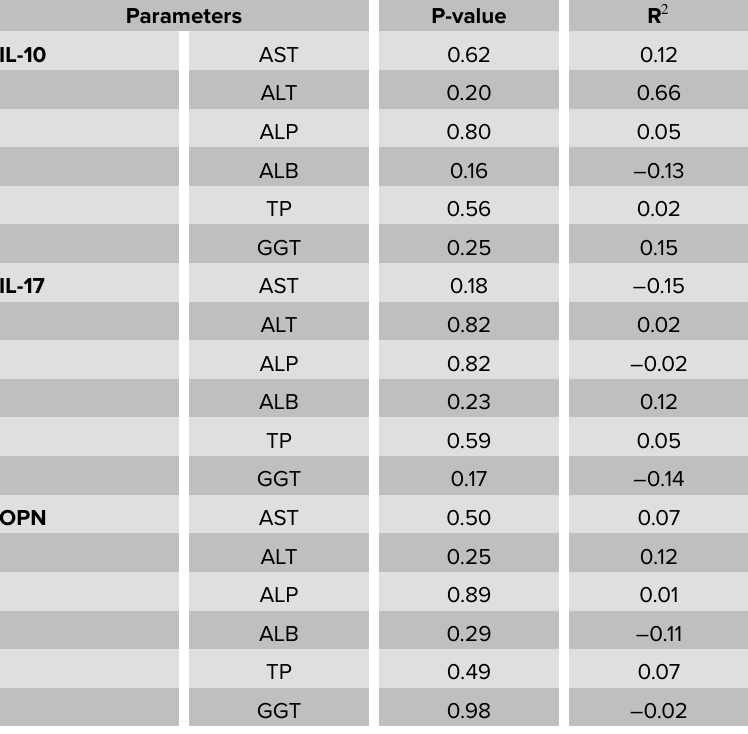
TABLE 5: Association between cytokines and liver function parameters (Pearson’s correlation results).